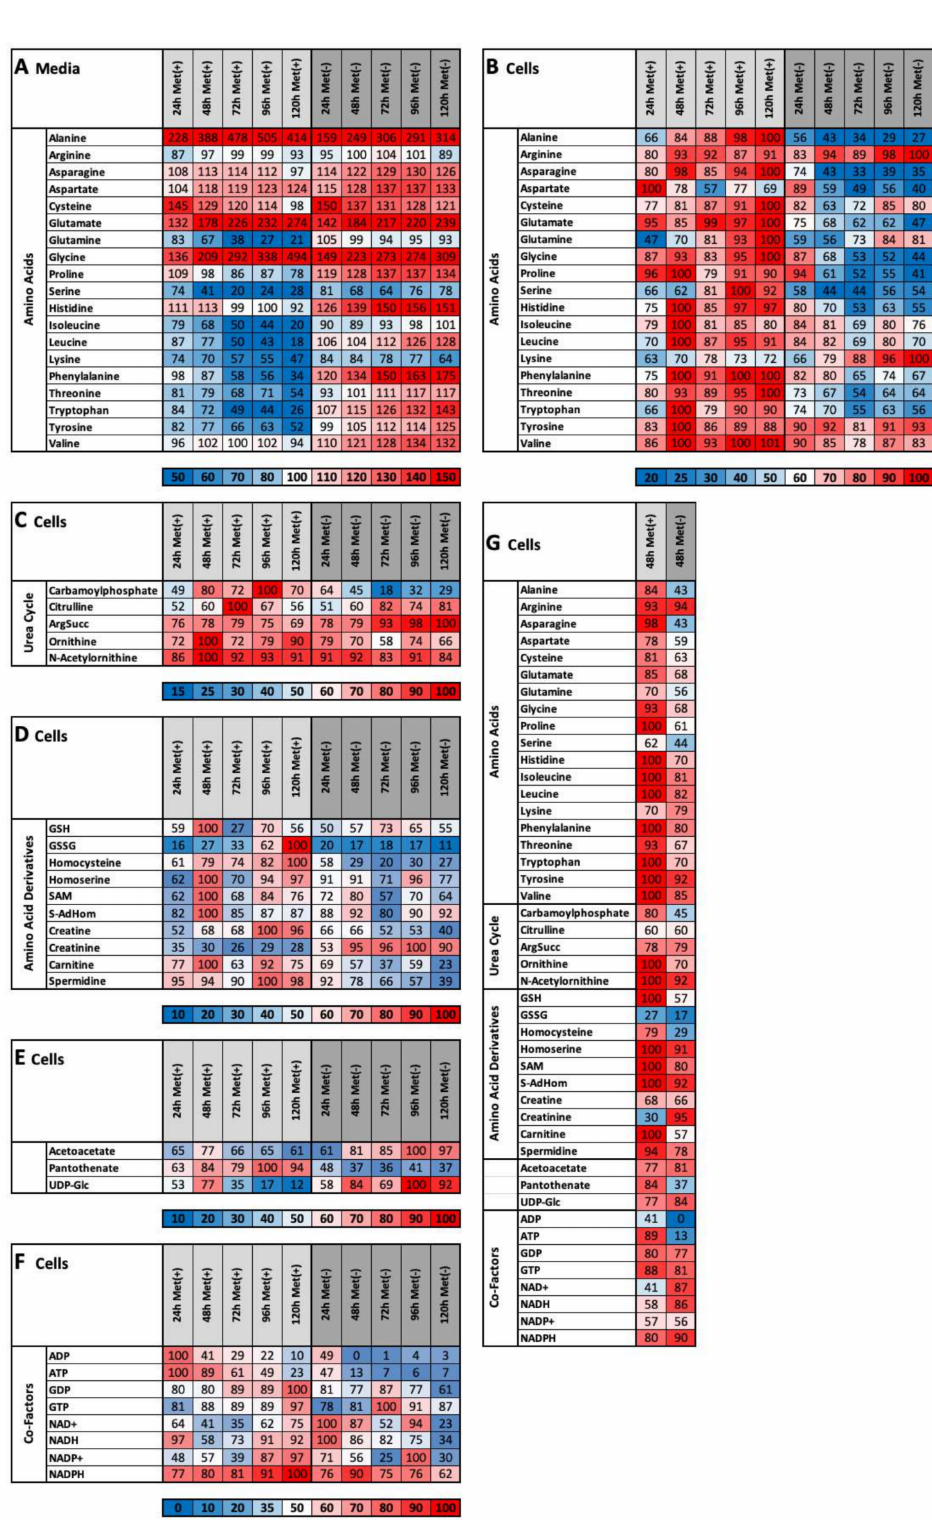
Figure 5. ( A – G ) Heat map overview of selected metabolites. The percentages of intracellular ( A ), extracellular ( B ) and nonproteinogenic (urea cycle) ( C ) amino acids, directly-cysteine-dependent ( D ) and indirectly-cysteine-dependent ( E ) amino acids and energy currencies ( F ) were determined as described in the Materials and Methods. ( G ) The results after 48 h that define the candidates for metabolic fingerprint are